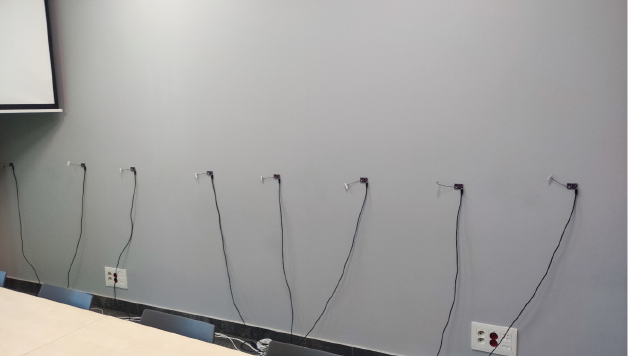
Figure 10. View of the wall of the test room subjected to the RTI system built with 32 probes—with a power